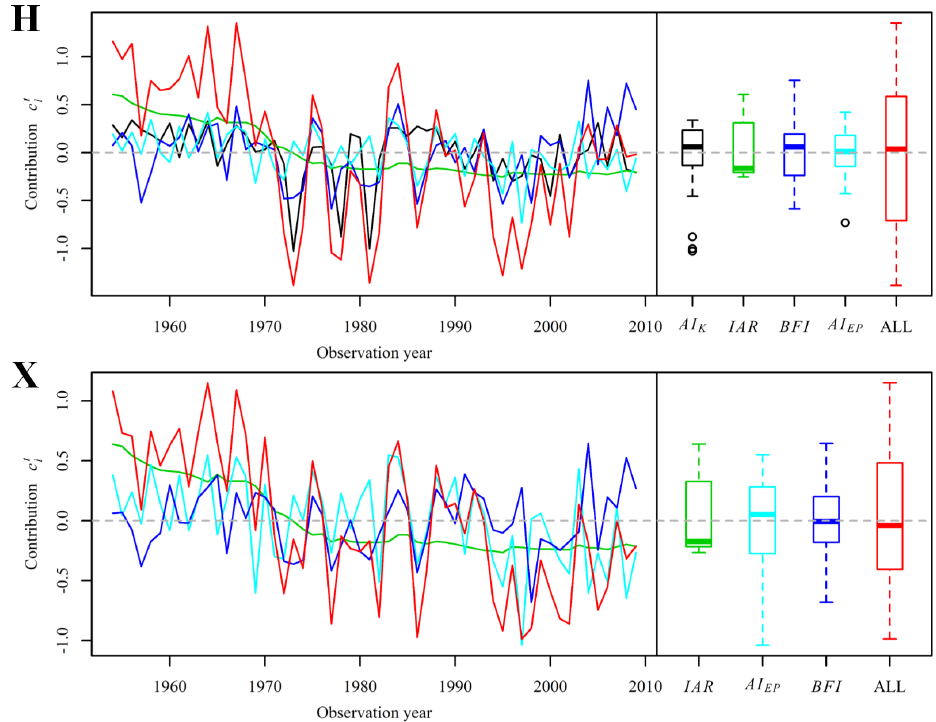
(cid:1) − ln (cid:0) θ (cid:1) in different periods based on = ln (cid:0) θ t 1 i 1